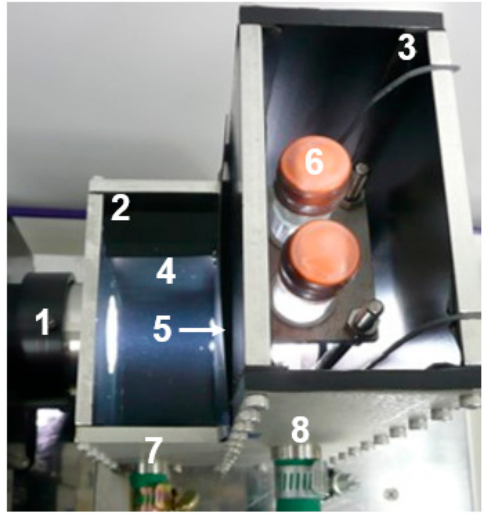
Figure 1. Photograph of photoreactor (top view): (1) Irradiation source (Xe lamp with cold mirror), (2) first part, (3) second part, (4) separating wall, (5) UV cut-off filter, (6) testing tube, (7) water inlet, (8) water outlet.